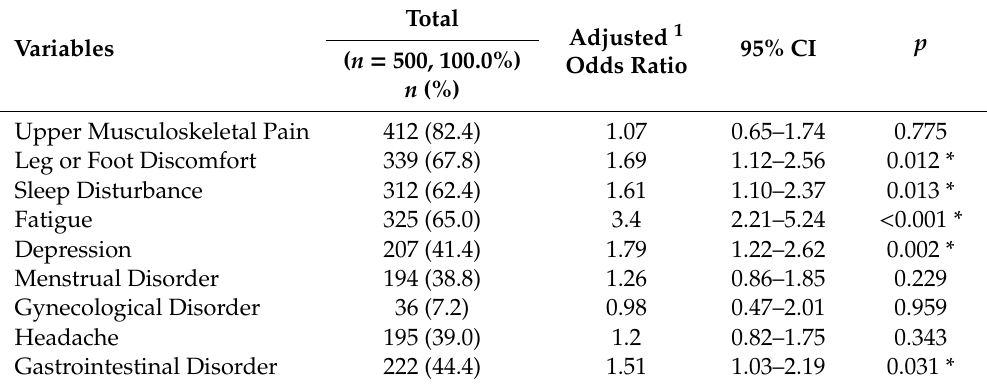
Table 2. Association between single health problems and turnover intention using a multiple ordinal logistic